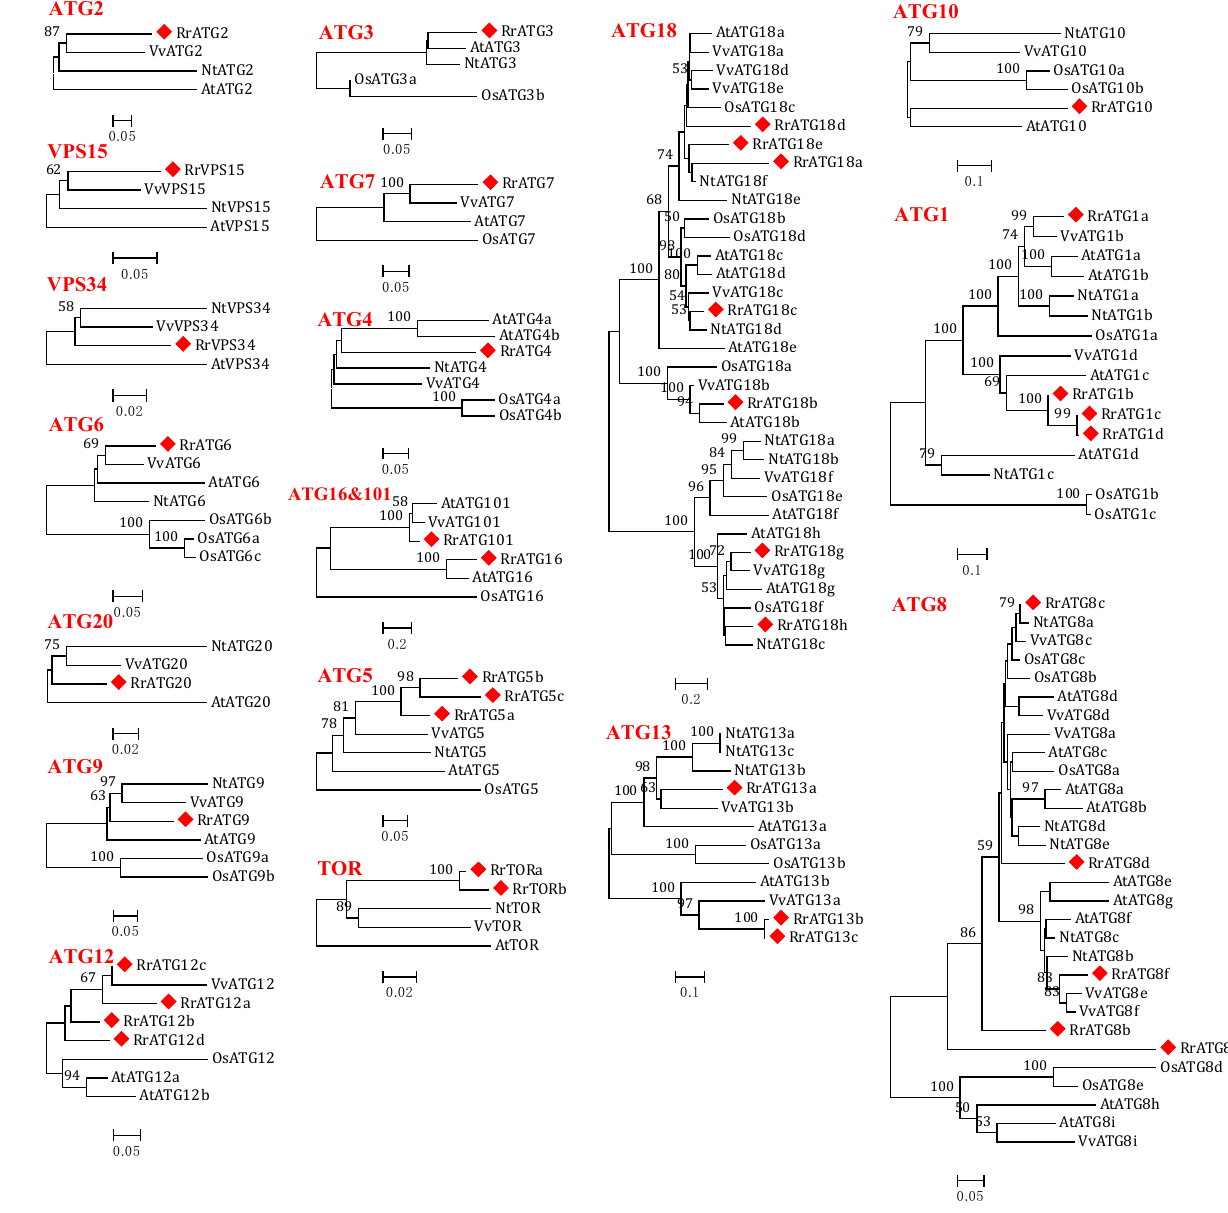
Figure 1. Phylogenetic trees were constructed using the neighbor-joining method with 1000 bootstrap values for ATG protein sequences of five species: R. roxburghii , Arabidopsis thaliana , Vitis vinifera , Nicotiana tabacum , and Oryza sativa . RrATG s are marked with red squares and bootstrap values below 50% are not shown in the phylogenetic